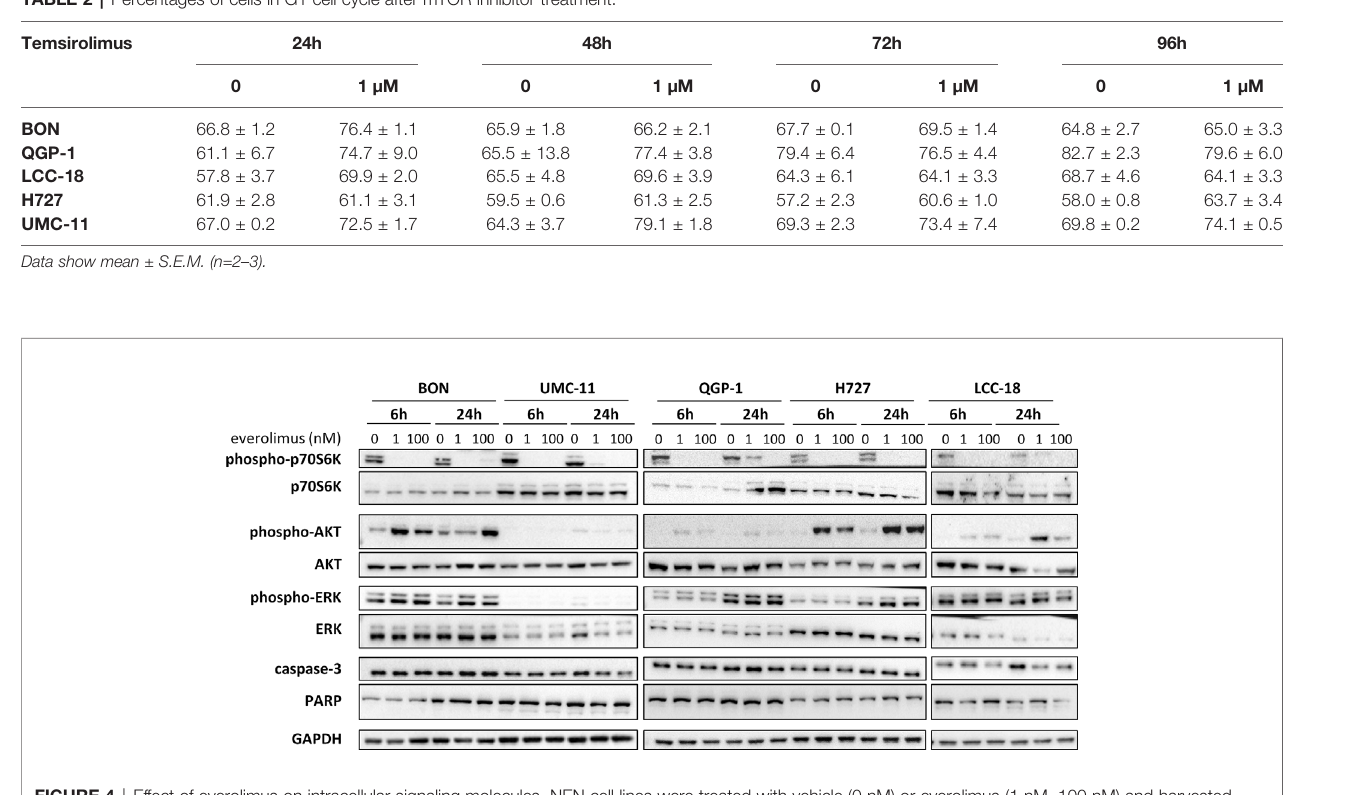
FIGURE 4 | Effect of everolimus on intracellular signaling molecules. NEN cell lines were treated with vehicle (0 nM) or everolimus (1 nM, 100 nM) and harvested after 6 and 24 h. Equal amounts of protein were separated on SDS gels and the indicated molecules detected after western